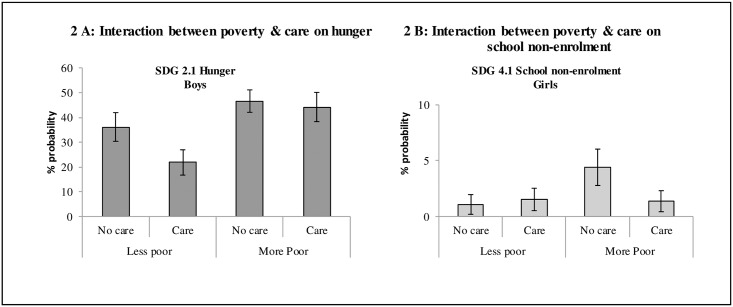
Panel A shows the predicted percent probabilities of adolescent hunger among boys for the interaction between missing necessities and receipt of ‘care’ provisions. Panel B shows the predicted percent probabilities of school non-enrolment among girls for the interaction between missing necessities and receipt of care provisions.